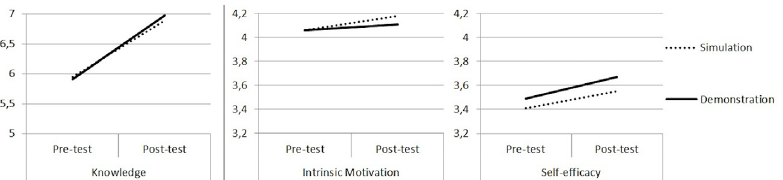
Fig 2. Visual representation of the change in knowledge, intrinsic motivation and self-efficacy for the vLAB and demonstration